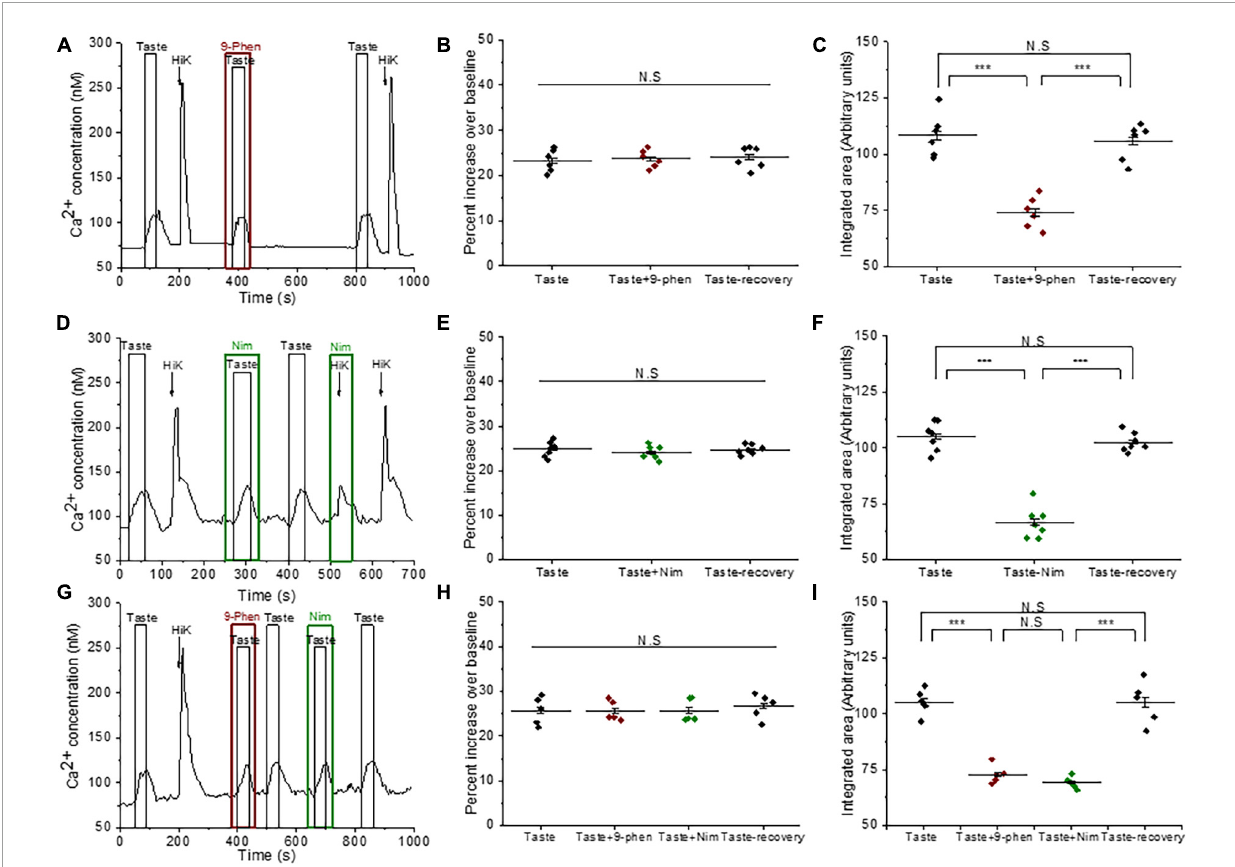
FIGURE5 The calcium influx by L-type VGCCs contributes to taste-evoked calcium responses in BR cells. (A) A representative calcium imaging trace showing inhibition of a taste-evoked calcium response by 9-phenanthrol (50 µ M). (B) Inhibiting TRPM4 did not significantly affect the amplitudes of the taste-evoked calcium responses ( F ( 2 , 15 ) = 0.16, p = 0.85), but caused a significant reduction in the signal magnitudes ( C , F ( 2 , 15 ) = 32.07, p = 0.0000038, n = 6 cells from 3 mice). (D) A representative calcium imaging trace showing inhibition of taste-evoked calcium responses by nimodipine (10 µ M). (E) Nimodipine did not inhibit the amplitudes of the taste-evoked responses ( F ( 2 , 18 ) = 0.48, p = 0.62), but significantly reduced the signal magnitudes ( F , F ( 2 , 18 ) = 89.55, p = 0.00000000044, n = 7 cells from 4 mice). (G–I) Similar results were observed when TRPM4 and L-type channels were independently blocked in the same BR cells (amplitude; F ( 3 , 16 ) = 0.17, p = 0.91) (magnitude; F ( 3 , 16 ) = 49.76, p = 0.000000025, n = 5 cells from 3 mice) (*** P < 0.001; N.S = Not